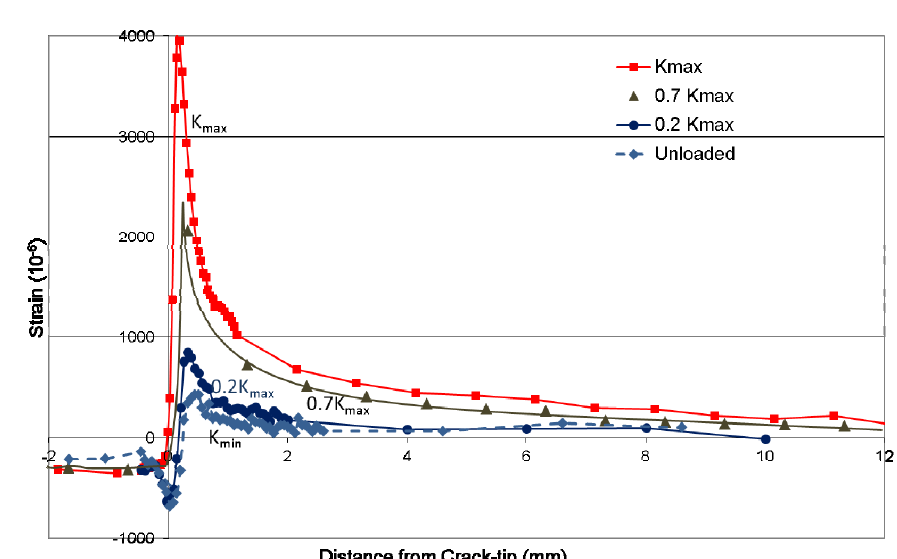
Figure 3: The variation in the crack opening elastic strain measured mid-thickness (z=0) along the crack plane (y=0) as the samples was unloaded from K max to K min at